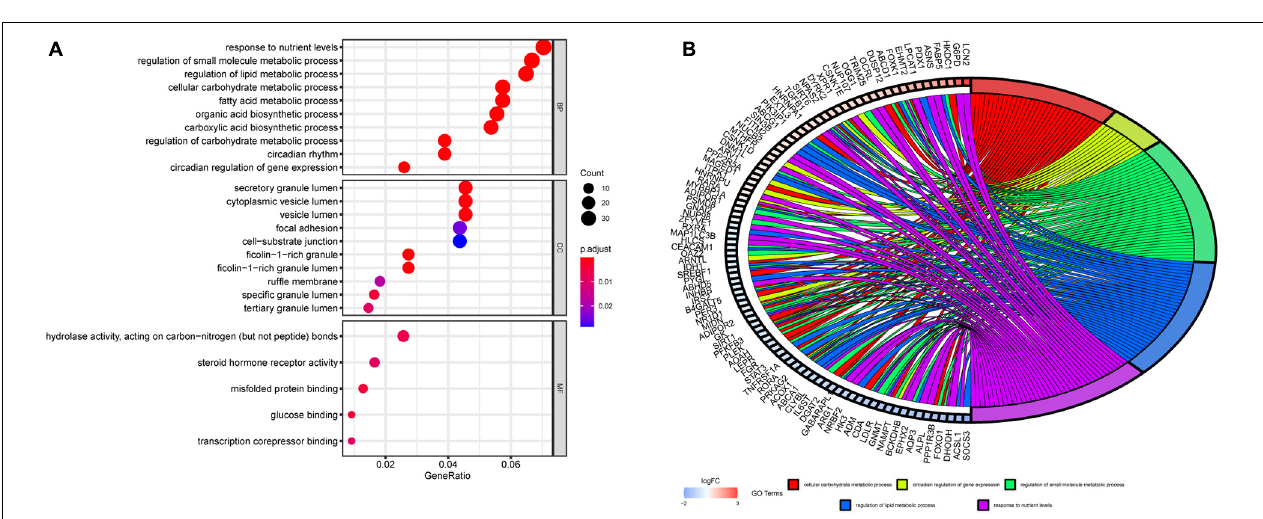
FIGURE 3 | GO enrichment analysis of DERGs. (A) Biological process, cell components, and molecular function enrichment analyses of DERGs. (B) GO cluster